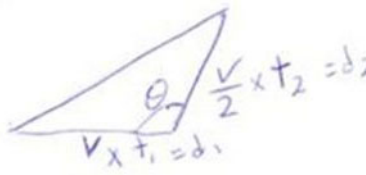
Figure 10. Nick’s graphical model-of the